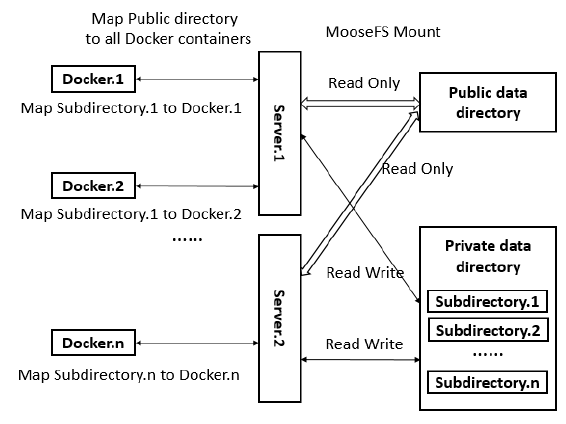
Figure 4. Data mapping